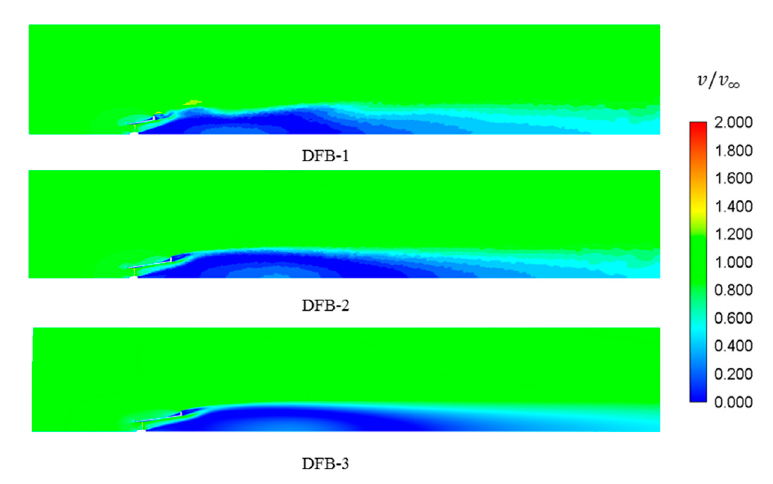
Figure 14. Normalized velocity in longitudinal plane at TSR = 5, turbine design DFB.